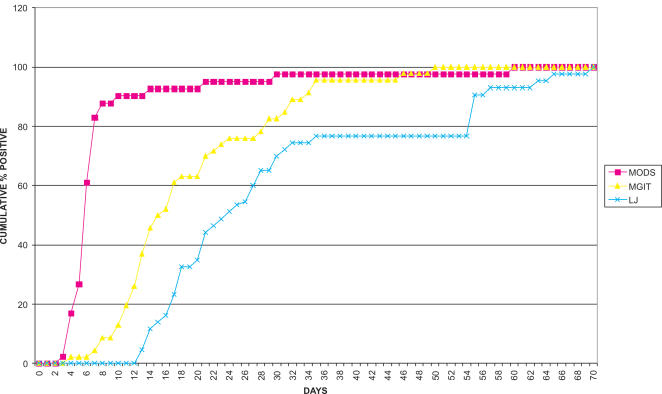
Cumulative percentage of positive cultures by day for MODS, MGIT and LJ culture.